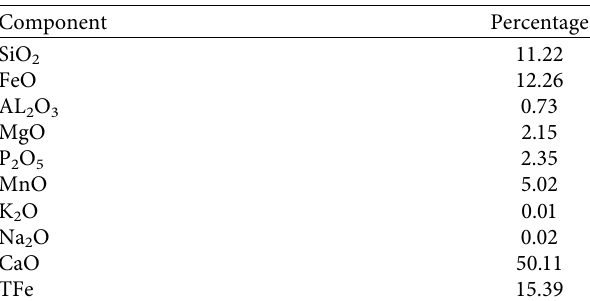
Table 5: Chemical analysis of